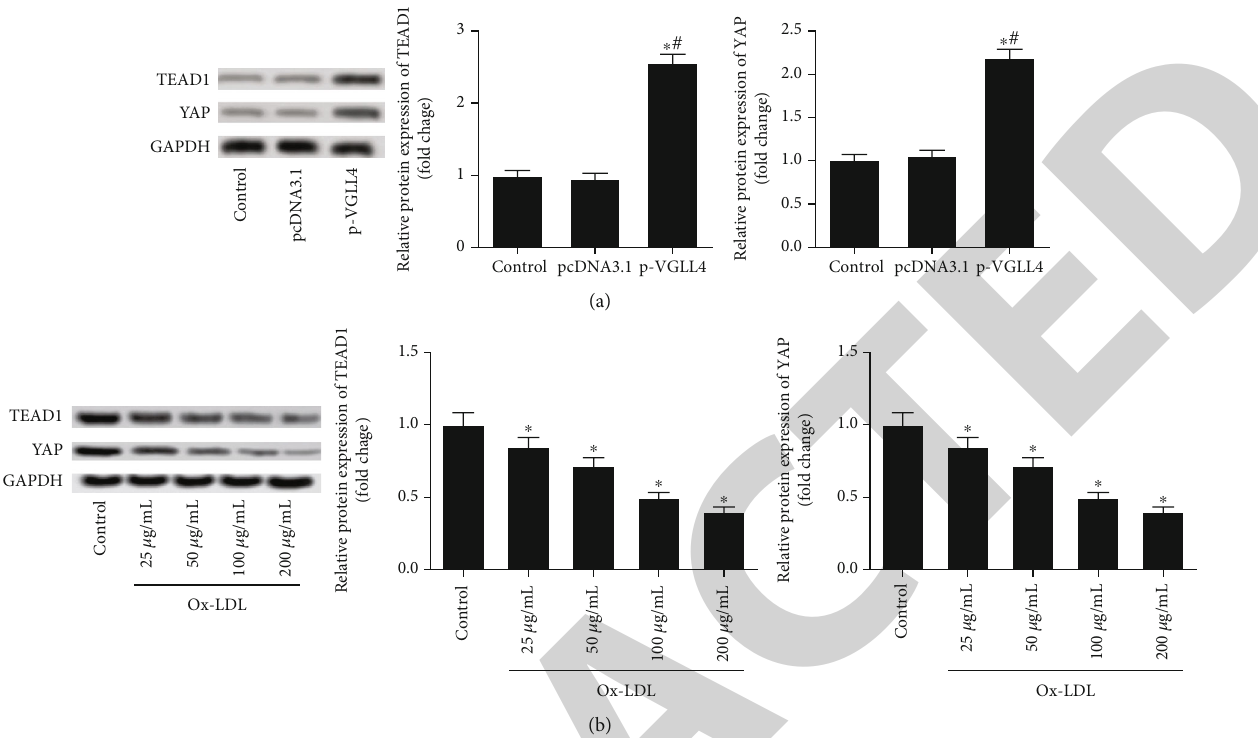
Figure 5: Overexpression of VGLL4 promotes the expression of TEAD1 and YAP, and Ox-LDL inhibits the expression of TEAD1 and YAP. (a) The protein expression of TEAD1 and YAP in the control, pcDNA3.1, and p-VGLL4 groups. (b) The protein expression of TEAD1 and YAP in HUVECs cells treated with Ox-LDL at 25, 50, 100, and 200 μ g/mL. “ ∗ ” means compared with the untreated group at P < 0 : 05 , and “ # ” means compared with the pcDNA3.1 group at P < 0 : 05 . GAPDH was used as an invariant internal control for calculating protein fold